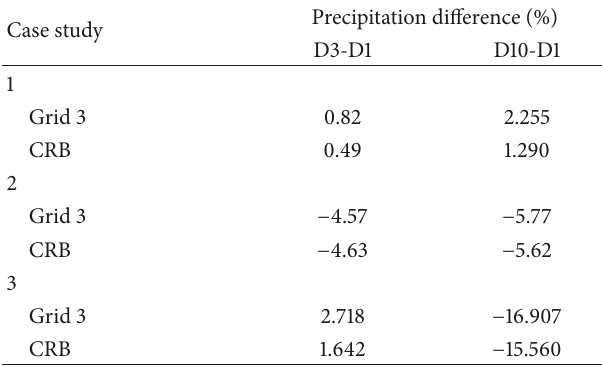
Table 3: Results of dust sensitivities in the three case